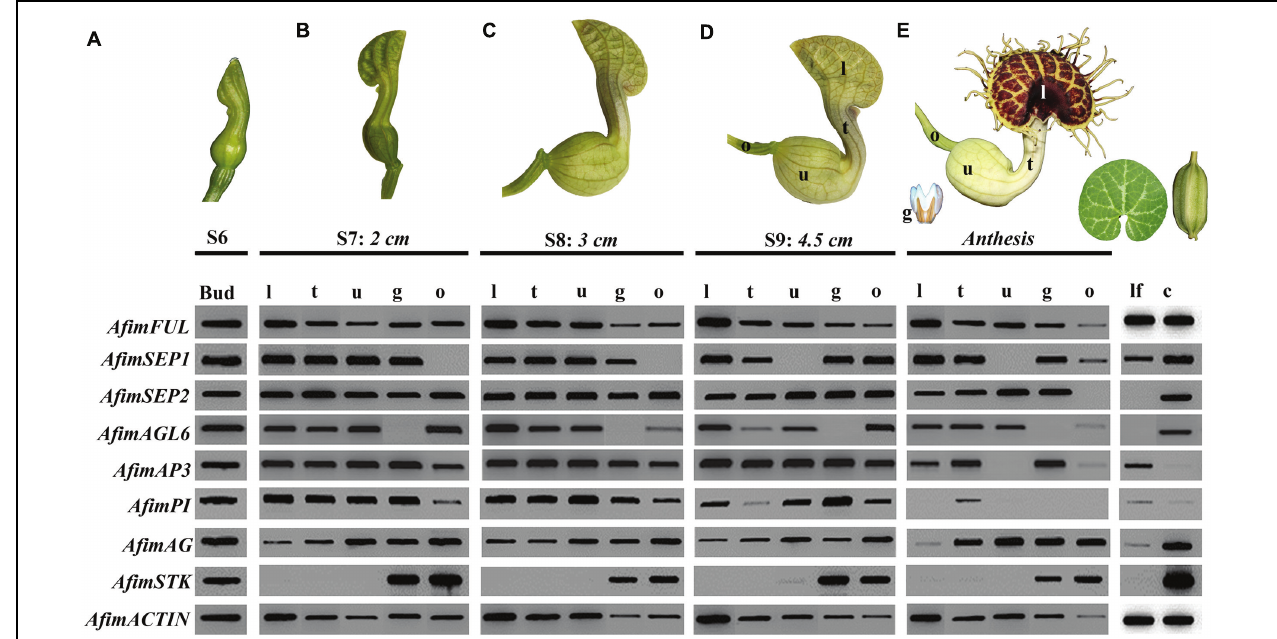
FIGURE 6 | Expression profiles of AfimFUL , AfimSEP1 , AfimSEP2 , AfimAGL6 , AfimAP3 , AfimPI , AfimAG, and AfimSTK at five different flower developmental stages (A–E), leaves (lf) and capsules (c). ACTIN ( AfimACT ) was used as a positive control. Measurements below each stage correspond to the total length of the perianth. From S7 onward (B) , flowers were dissected into gynostemium (g), limb (l), ovary (o), tube (t), and utricle (u).